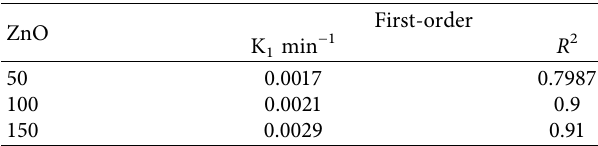
Figure 8: Pseudo-first-order model for degradation of PW using ZnO at pH � 6.5. Table 2: Rate constants using